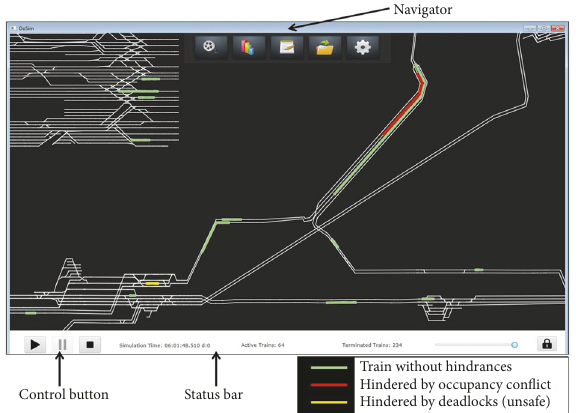
Figure 2: Screenshot of “Network/Train Run” view in PULSim.